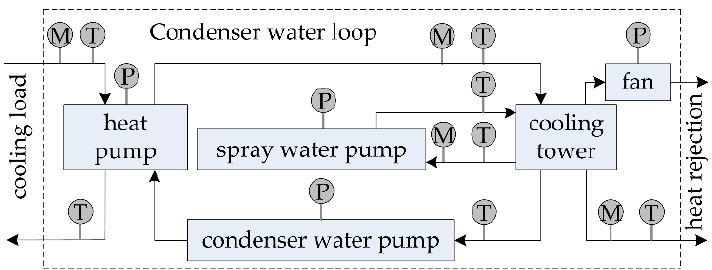
Figure 1. Schematic diagram of the CTAHP system under cooling conditions. M , T and P indicate the mass flow rate, temperature and input power measurements, respectively.